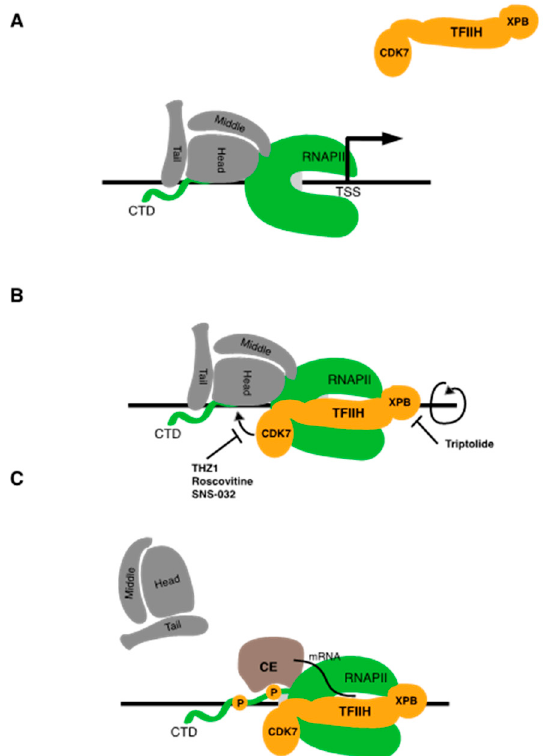
Figure 2. Inhibition of TFIIH blocks RNAPII transcription initiation. ( A ) TFIIH associates with the RNAPII–Mediator complex bound at the core promoter. ( B , C ) ATP-dependent DNA translocase activity of XPB leads to unwinding of promoter DNA, while phosphorylation of CTD serine 5 residues (orange circles) leads to dissociation of Mediator and binding of the mRNA capping enzymes (CE). Inhibitors of TFIIH-associated activities discussed in the text are indicated.